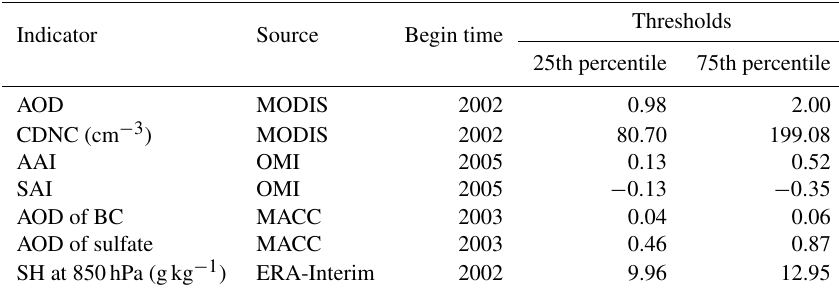
Table 1. The indicators of aerosols and moisture used in the study and their sources, begin times and the thresholds (25th and 75th percentiles). The end time of all data is to